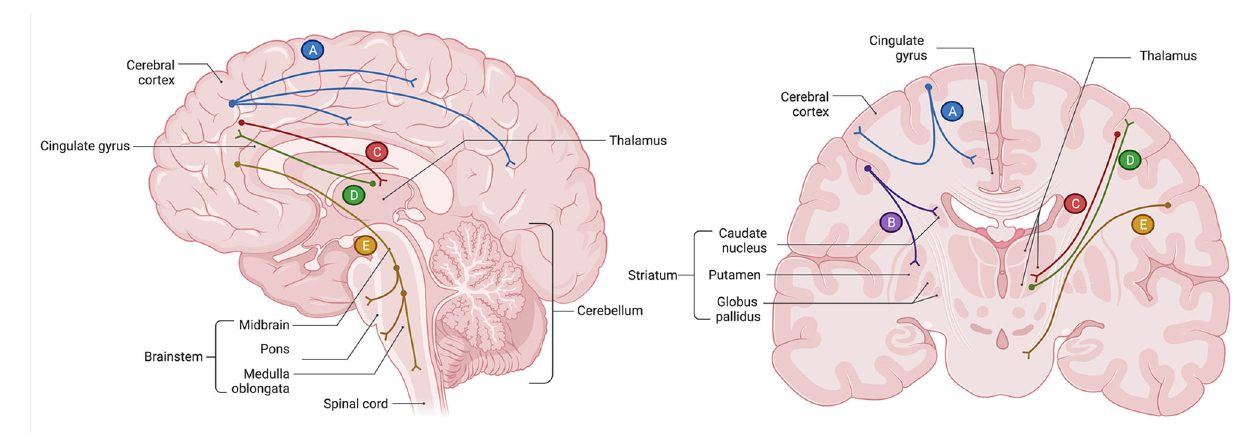
FIGURE 1 | Glutamatergic circuitry of the human brain: five cortical pathways (35, 36). (A) The cortico-cortical glutamate pathways constitute regions within the cerebral cortex, including the prefrontal cortex (PFC), that communicate with each other via glutamatergic pyramidal neurons. Axons of those neurons form white matter commissural fibers that interconnect cortical regions between two cerebral hemispheres, as well as short (U-fibers) and long association fibers that interconnect cortical regions within the same cerebral hemisphere. (B) The cortico-striatal glutamate pathway is a descending pathway that originates in the PFC and projects to the regions of the striatum, including the nucleus accumbens (NAc) of the ventral striatum. This pathway comprises the “cortico-striatal” portion of cortico-striatal-thalamic loops. (C) The cortico-brainstem glutamate pathways are comprised of white matter projection fibers that originate in the pyramidal neurons of the cerebral cortex, including the PFC, and descend to the major neurotransmitter centers situated in the nuclei of the brainstem. This pathway regulates the release of other neurotransmitters, notably the monoamines norepinephrine, serotonin, and dopamine, as well as gamma-aminobutyric acid (GABA). (D) The cortico-thalamic glutamate pathway is a descending projection that originates in the pyramidal neurons of the cerebral cortex, including those of the PFC, and innervates the thalamus (TH). (E) The thalamo-cortical glutamate pathway is an ascending pathway that originates in the neurons of the TH and terminates in the pyramidal neurons of the cerebral cortex, including those of the PFC. All cortical glutamatergic pathways involve the PFC, which carries a functional significance to the cognitive, behavioral, and affective symptoms of major depressive disorder (MDD) when glutamatergic circuits are dysregulated. Created with BioRender.com, RRID:SCR_018361.